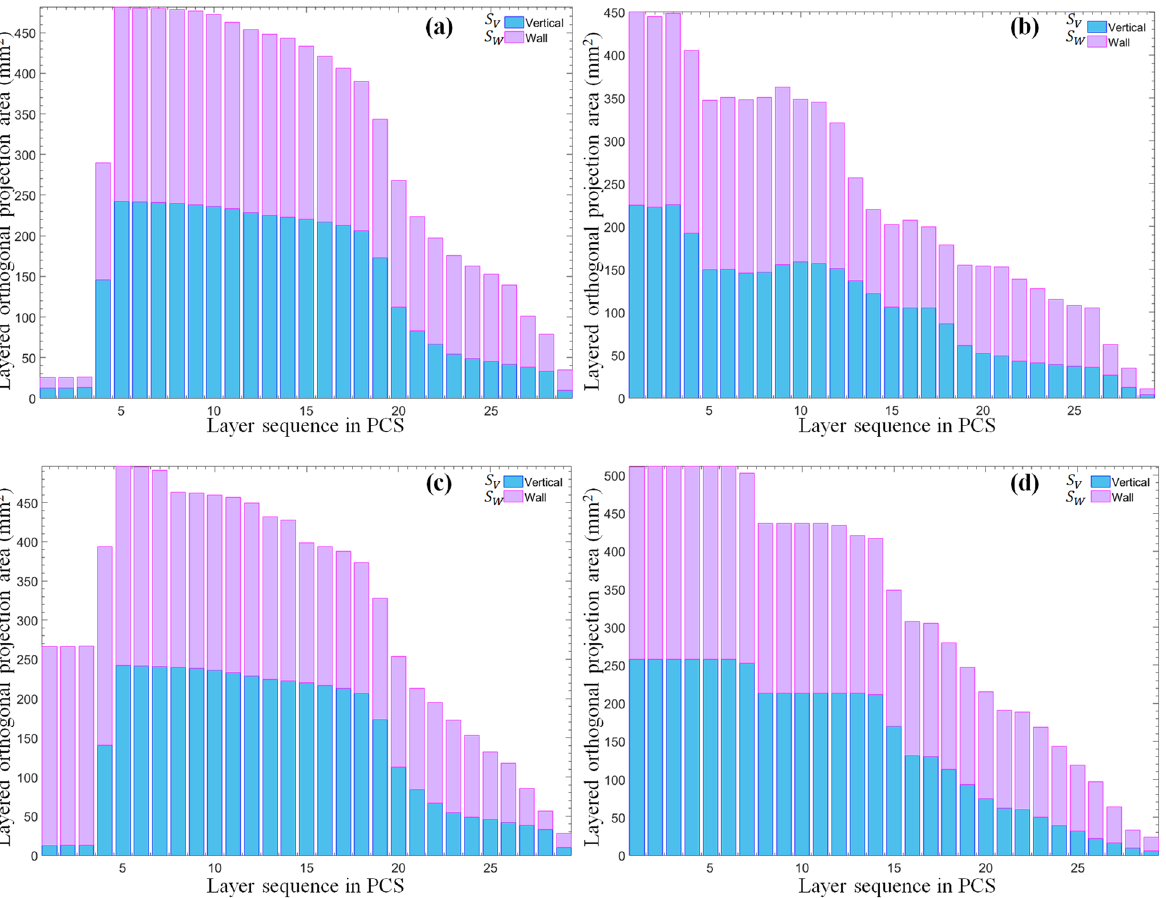
Fig. 9 Layered orthogonal projection areas of two typical supports where a represents the original manifold and b represents the external support manifold of tree type; c represents the original manifold and d represents the external support manifold of linear type